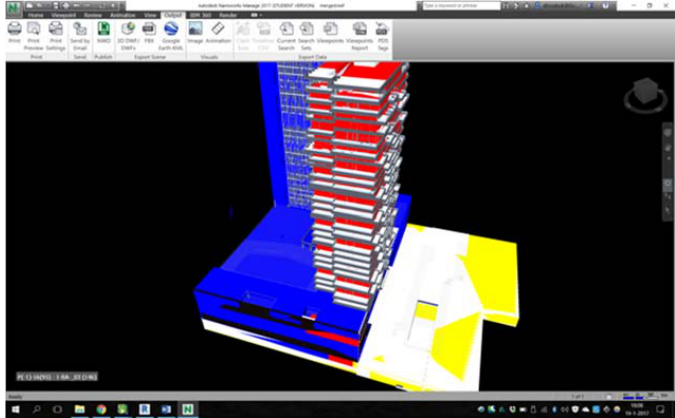
Figure 8. Integration of the legal model and the physical model (Amsterdam case) shows that these are not consistent.